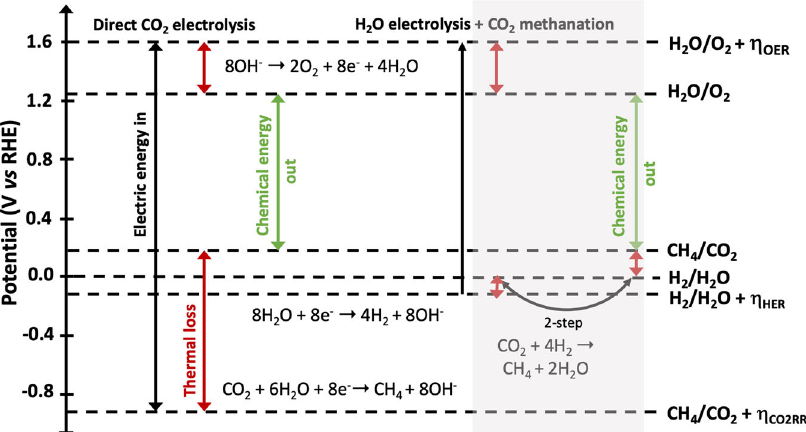
Fig. 6 Energy scheme showing the energy inputs and outputs for direct CO 2 electrolysis and H 2 O electrolysis combined with CO 2 methanation. Energy lost as heat is marked in red. Redrawn from Sheehan (2021) 59